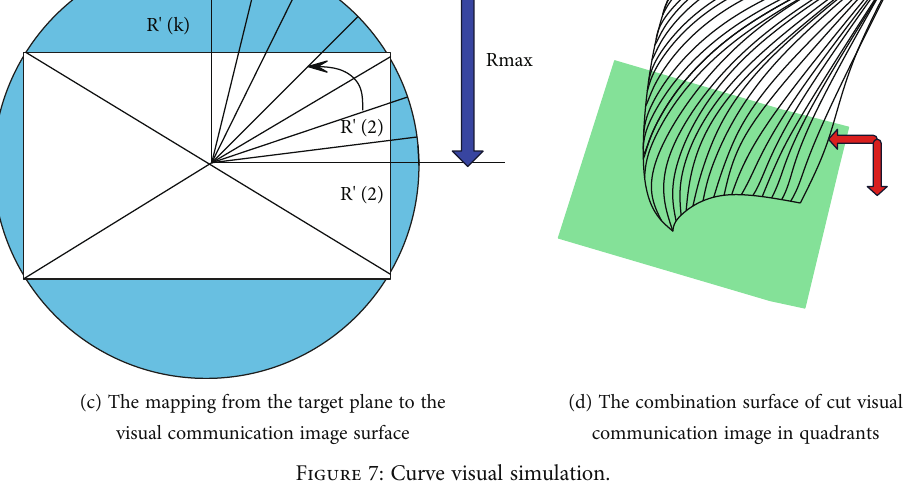
Figure 7: Curve visual simulation.